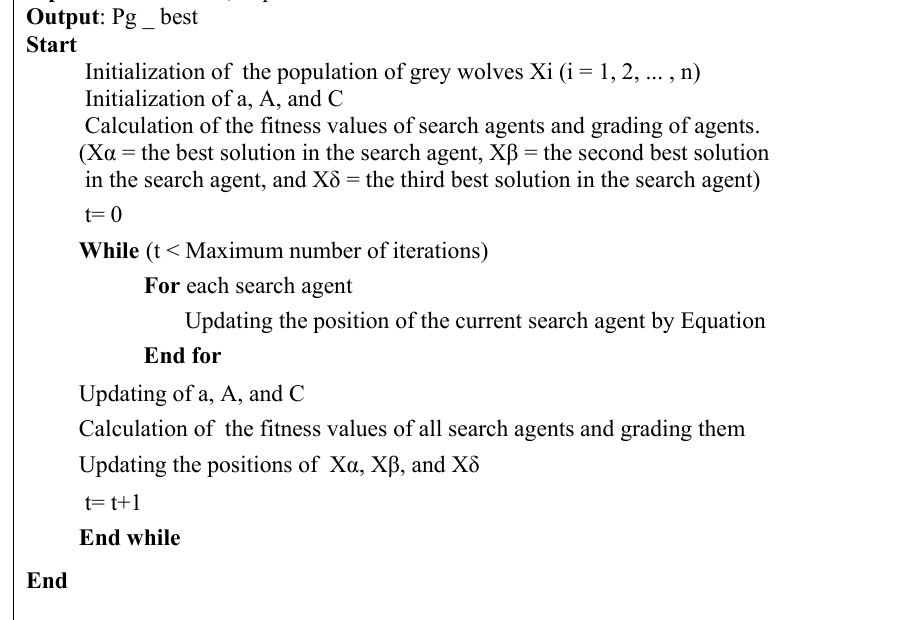
Fig. 2. Pseudocode of grey wolf optimization algorithm.